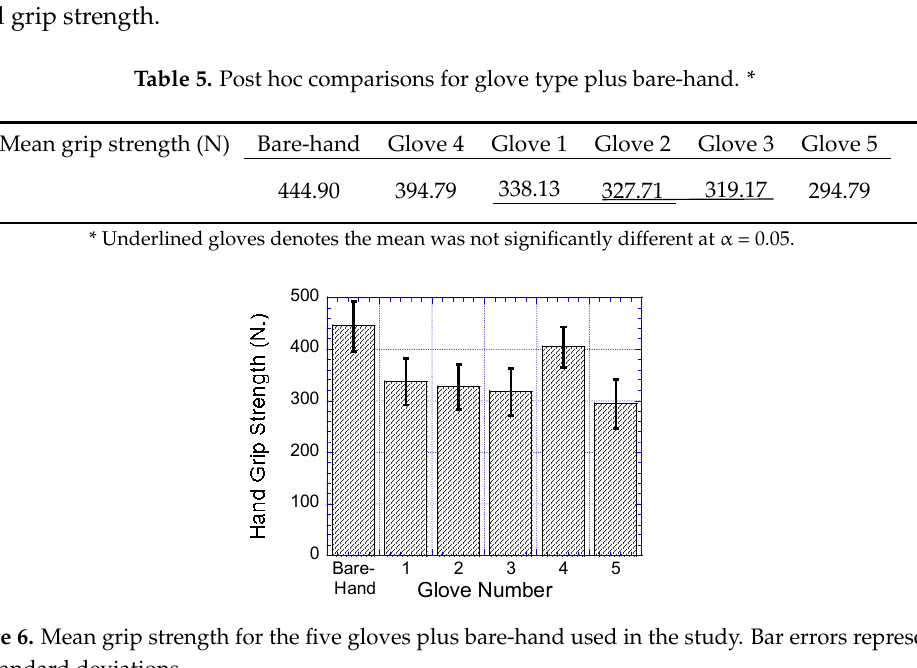
Figure 5. Comparison of grip strength percentage reduction due to cooling skin temperature, and percentage increase in grip strength due to raising hand skin temperature when compared to 25 °C hand skin temperature. Bar errors represent the standard deviations.